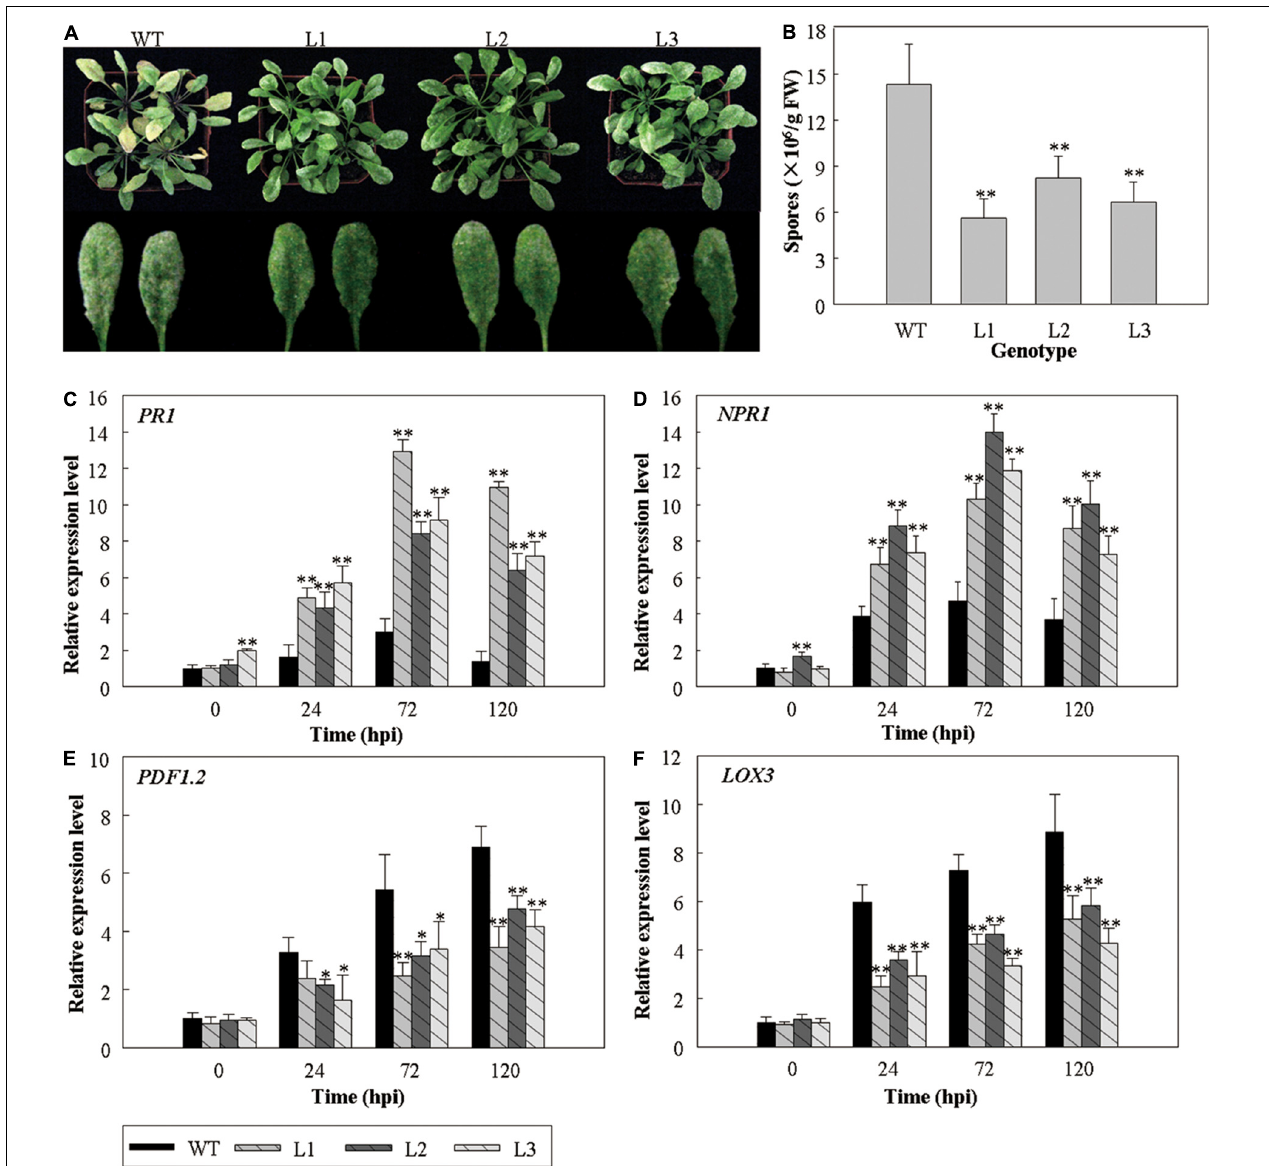
FIGURE 8 | The response of VlWRKY3 transgenic Arabidopsis thaliana to Golovinomyces cichoracearum inoculation. (A) The phenotype of transgenic and WT plants post infection for 5 days. (B) Bacteria numbers per gram of fresh leaf tissue 5 days post infection. (C–F) The relative expression levels of PR1 (C) , NPR1 (D) , PDF1.2 (E) and LOX3 (F) in WT and VlWRKY3 transgenic A. thaliana plants following G. cichoracearum infection. Relative gene expression levels were analyzed using quantitative RT-PCR. Bars represent the mean values ± SD of three independent experiments. Asterisks indicate statistical significance ( ∗ 0.01 < P <